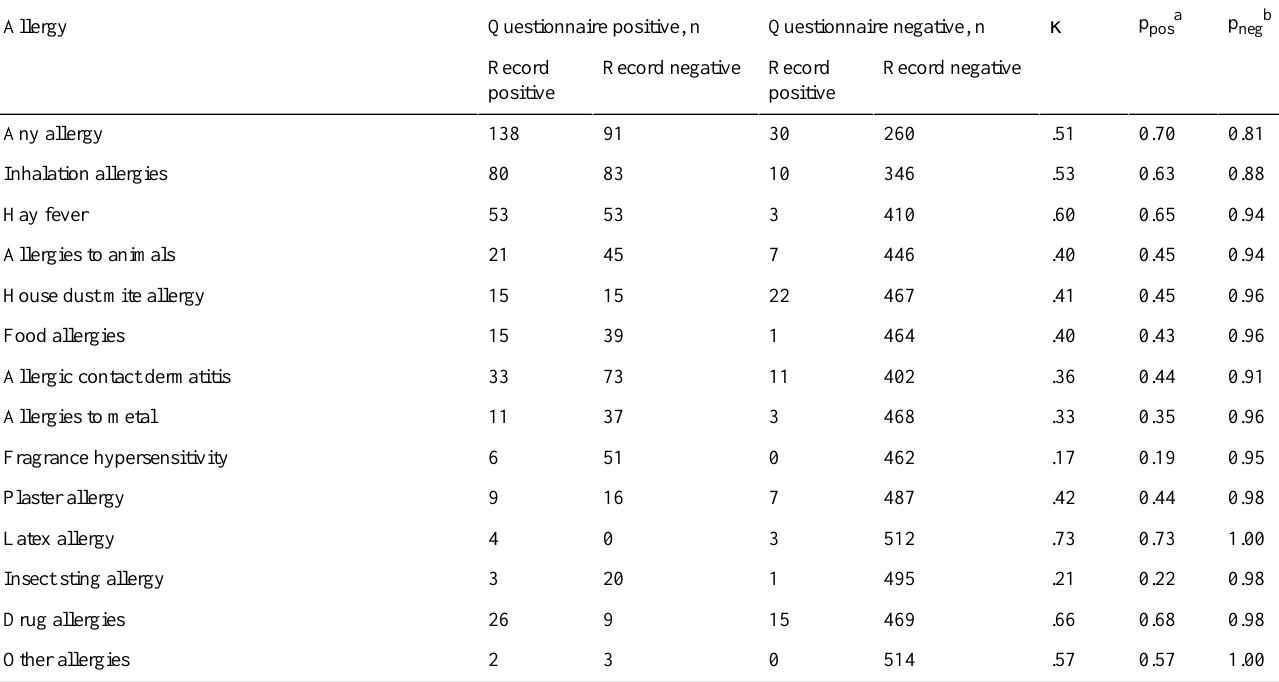
Table 3. Agreement between data from a Web-based questionnaire and obstetric record for allergies